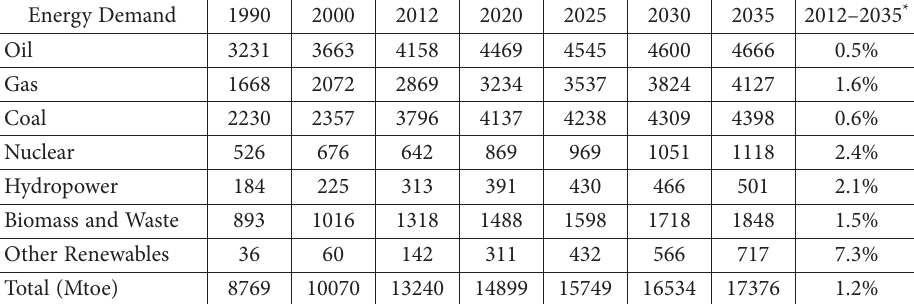
Table 1. World primary energy demand by fuel (Mtoe) (WEO 2014) Energy